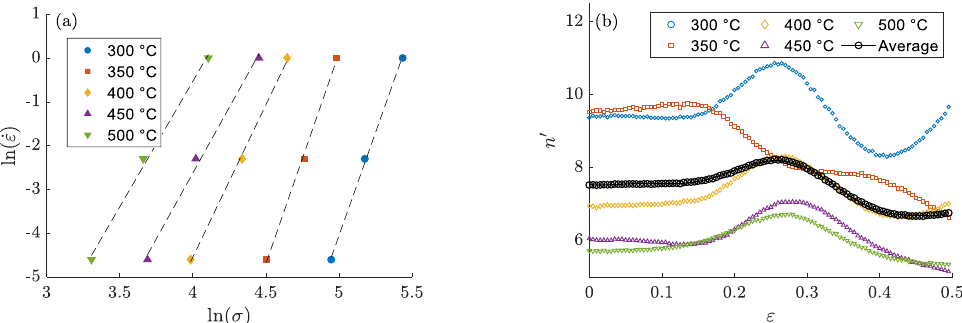
Figure 1. ( a ) The linear plots for determining n (cid:48) , and ( b ) the values of n (cid:48) and their temperature- averaged determined as functions of strain. The discrete symbols of the “averaging” set shows the obtained values from the measured values, and the continuous line represents the fitted